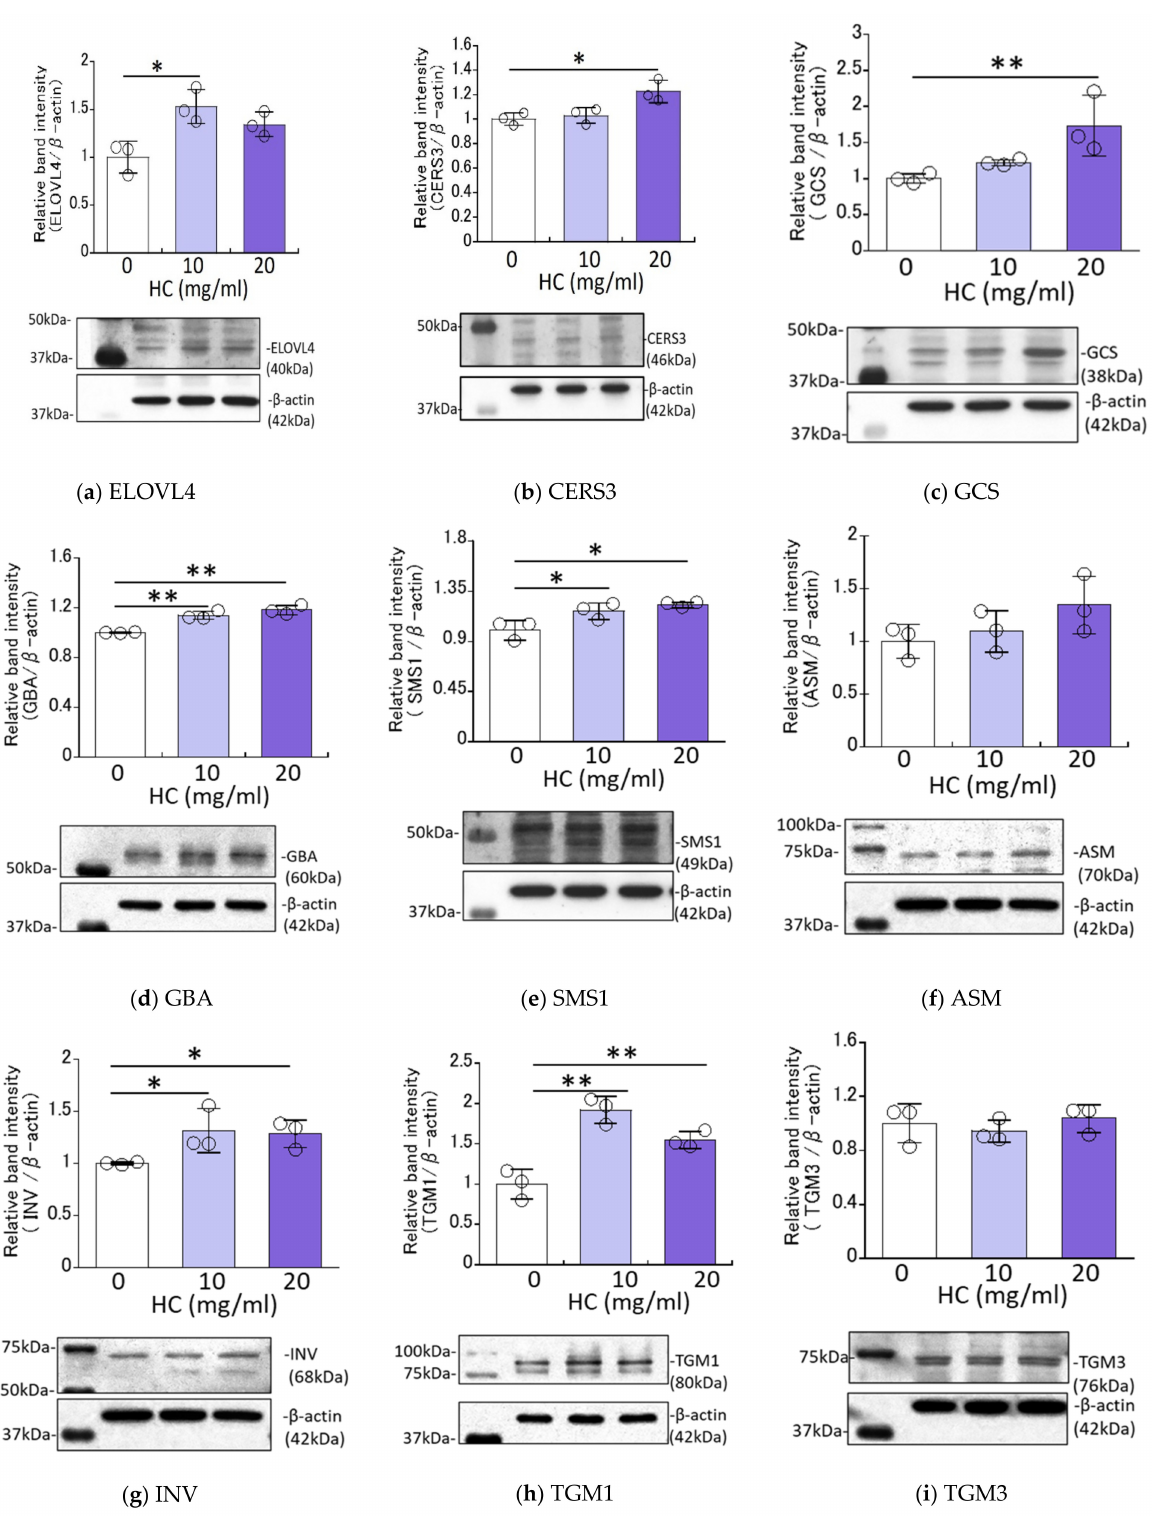
Figure 4. Effect of HC on expression levels of ceramide synthesis- and keratinization-related proteins in RHEEs. ( a ) ELOVL4, ( b ) CERS3, ( c ) GCS, ( d ) GBA, ( e ) SMS1, ( f ) ASM, ( g ) INV, ( h ) TGM1, ( i ) TGM3. RHEEs were treated with HC (at 0, 10 and 20 mg/mL) for 4 days and total proteins were extracted. Protein expression levels were determined by Western blotting as described in the Section 4 Materials and Methods and are expressed as each protein level/ β -actin. Bars represent means ± SD, n = 3, Dunnett’s multiple comparison test. *: p < 0.05, **: p <